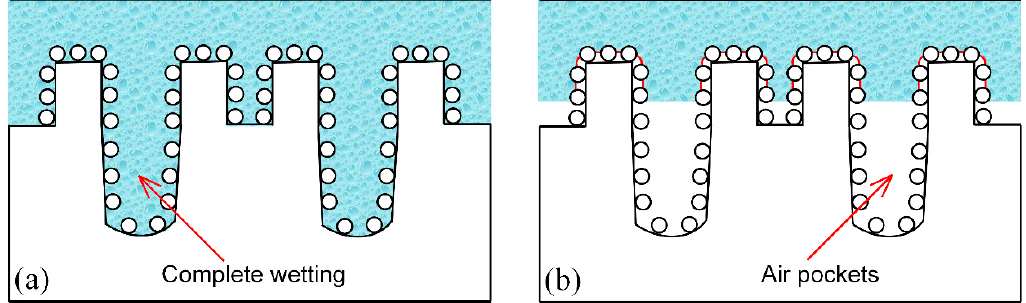
Figure 7. The wetting model of the water droplet on the laser-induced surfaces with hierarchical topographies: ( a ) initial super-hydrophilic surface, ( b ) aged super-hydrophobic surface.